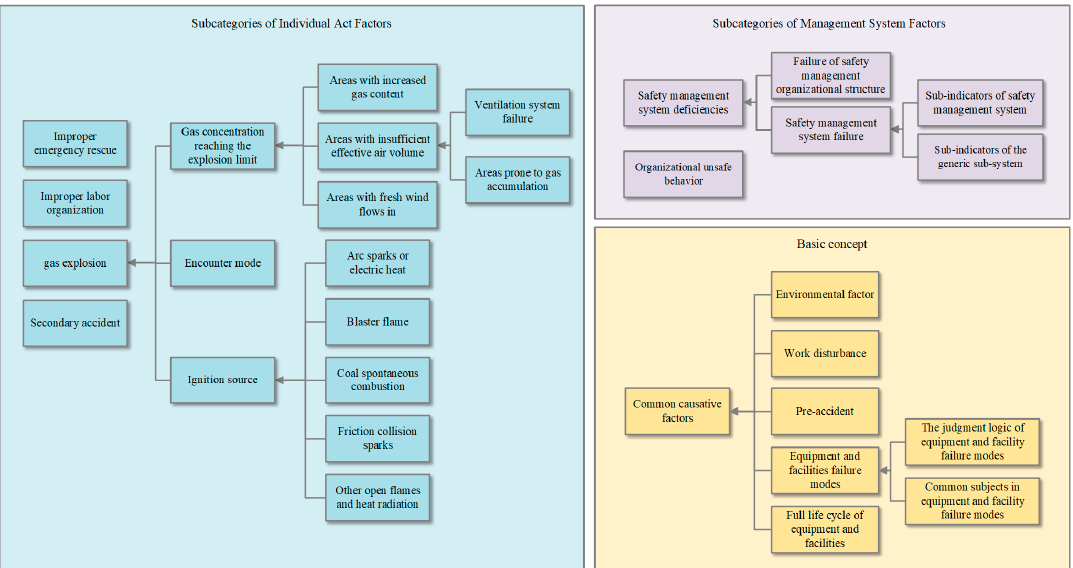
Figure 4. Summary of subcategories for the classification of coal mine gas explosion accident causes.